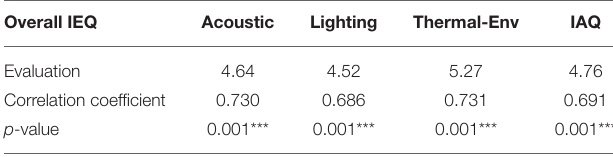
TABLE 3 | Correlations between IEQ and four environmental parameters. TABLE 4 | Evaluation of four